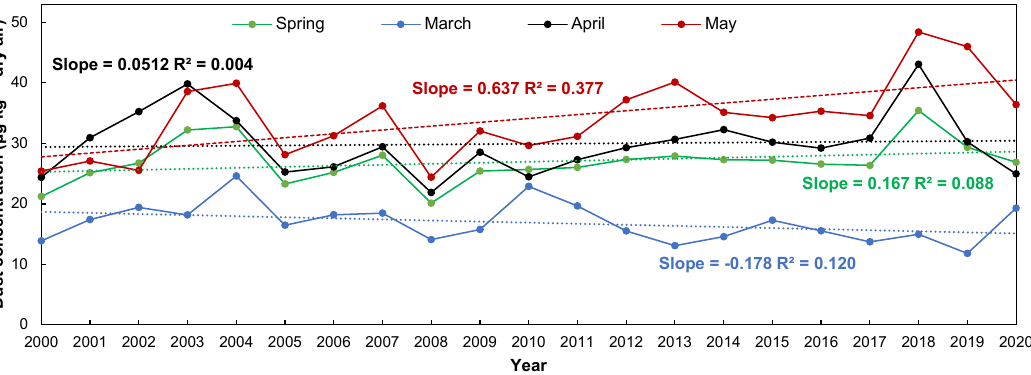
Figure 4. Interannual variations in dust concentrations in March (blue line), April (black line), May (red line), and spring (green line) during 2000 − 2020 in China.